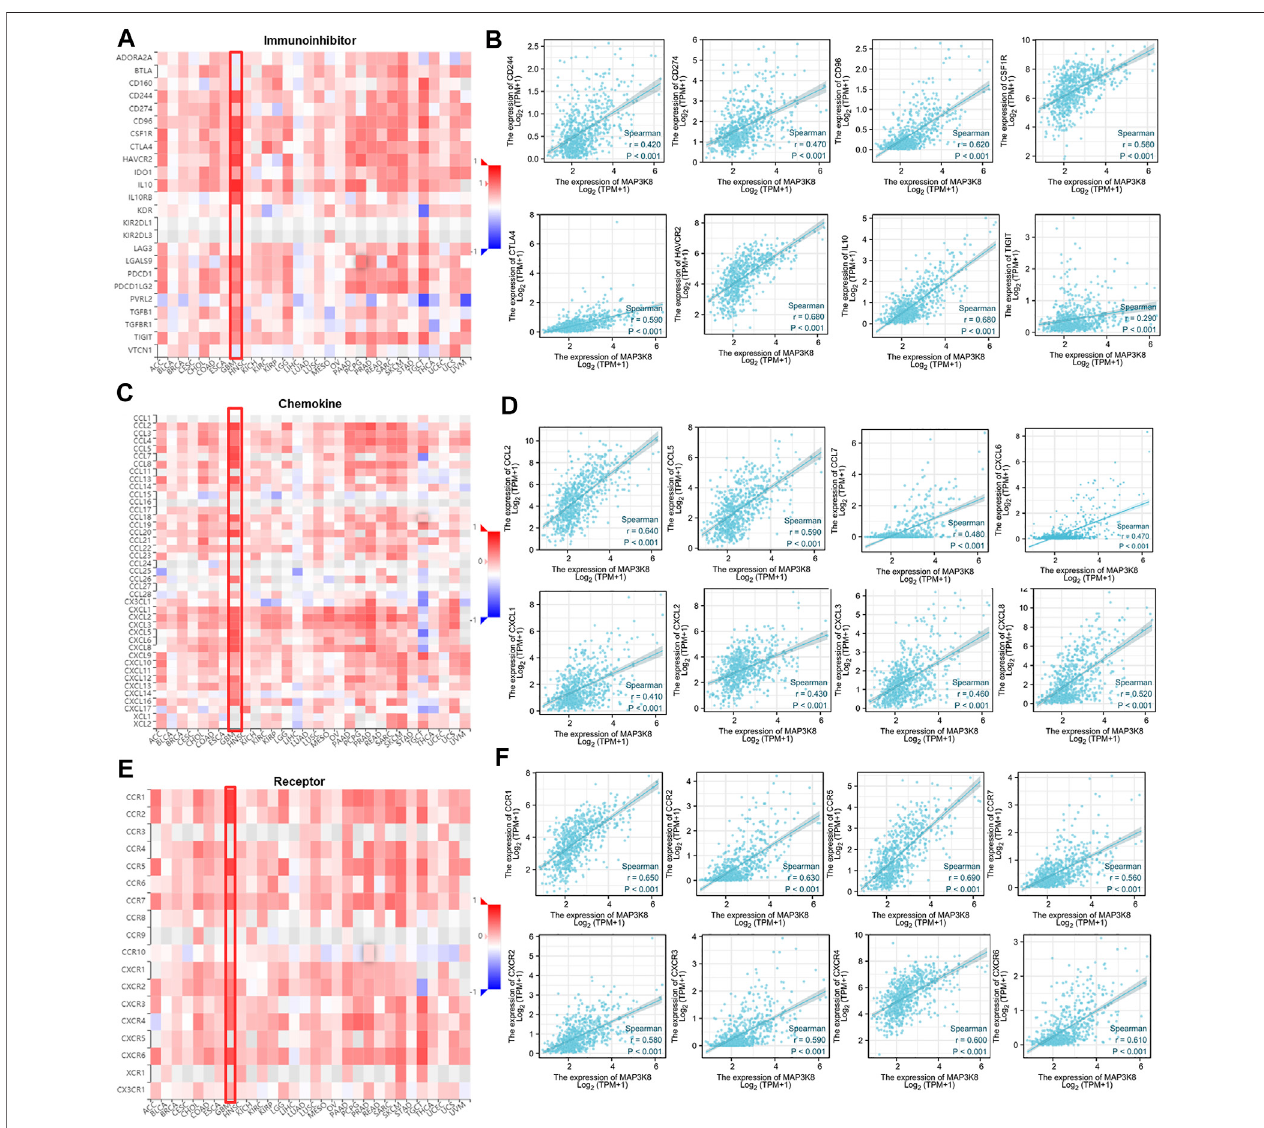
FIGURE 7 | Correlations between MAP3K8 expression and the expressions of immune inhibitors, chemokines, and chemokine receptor. (A , C , E) Correlations between the expressions of MAP3K8 and immune inhibitors (A) , chemokines (C) , and chemokine receptors (E) across human cancers. (B , D , F) Correlations between the expressions of MAP3K8 and immune inhibitors (B) , chemokines (D) , and chemokine receptors (F) in glioma from The Cancer Genome Atlas (TCGA) dataset.